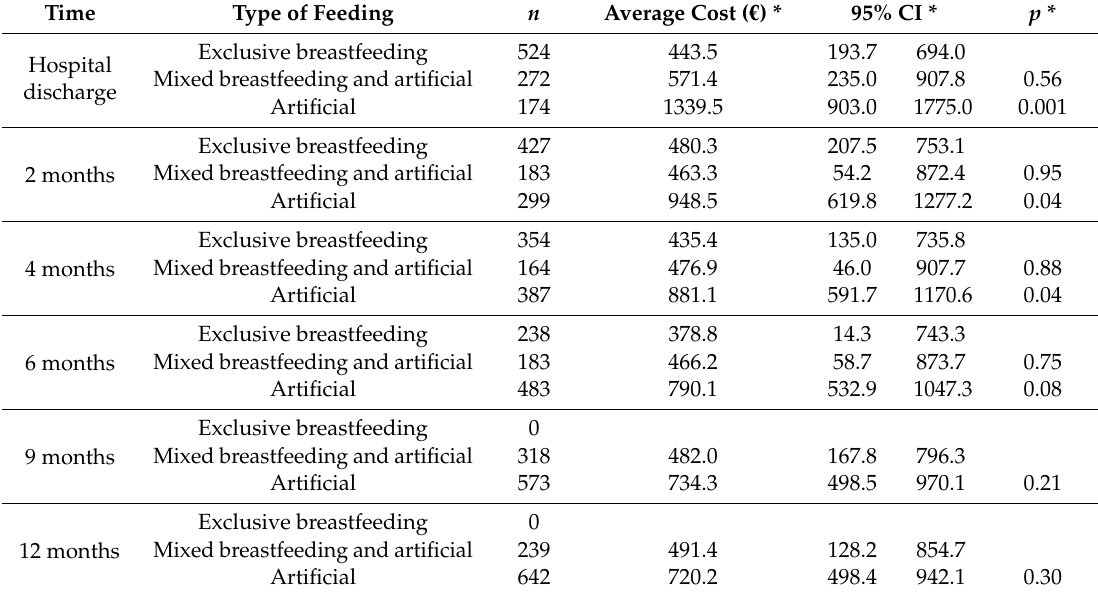
Table 5. Relationship between type of feeding and all costs due to infectious